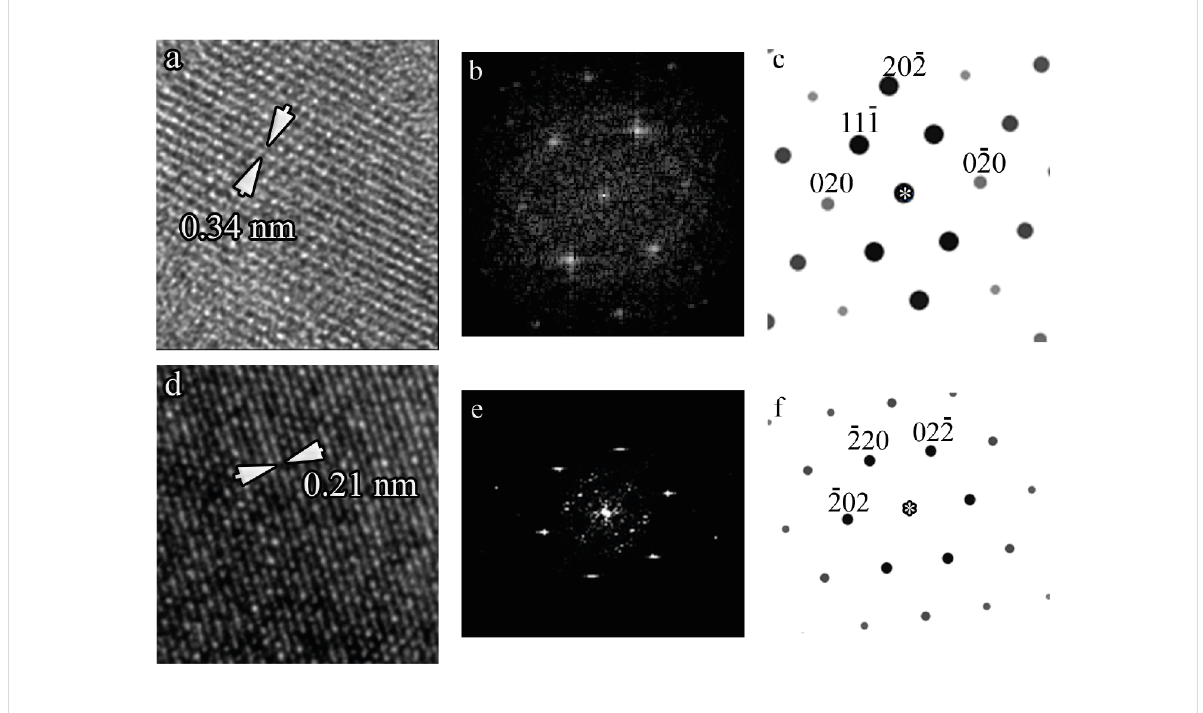
Figure 5: (a,d) HRTEM images of sample areas. (b,e) Corresponding two-dimensional Fourier spectra. (c,f) Calculated electronograms of the cubic MnGaSb 2 compound in [101] (c) and [111] (f)